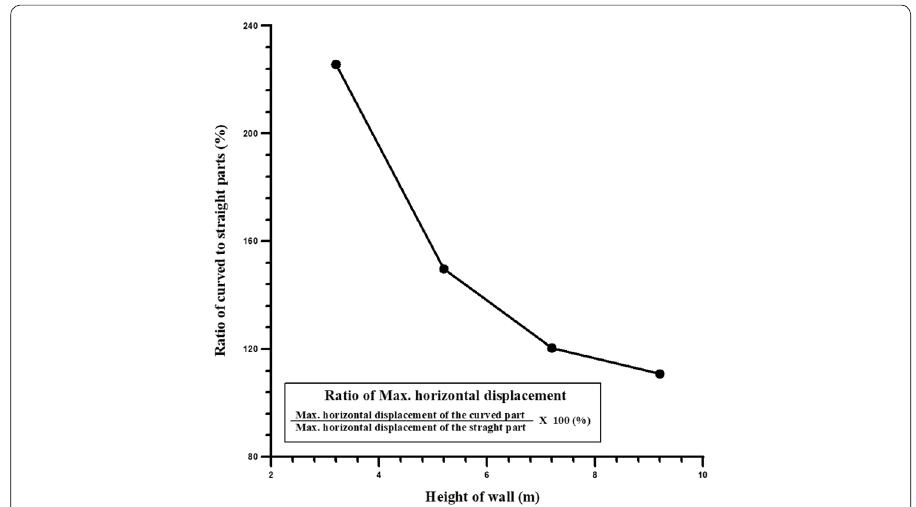
Fig. 15 Ratio of maximum horizontal displacement